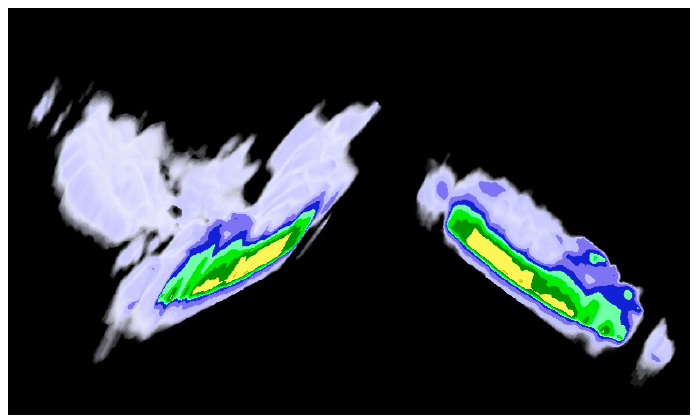
Figure 17. Cutting analysis of meteorological space.